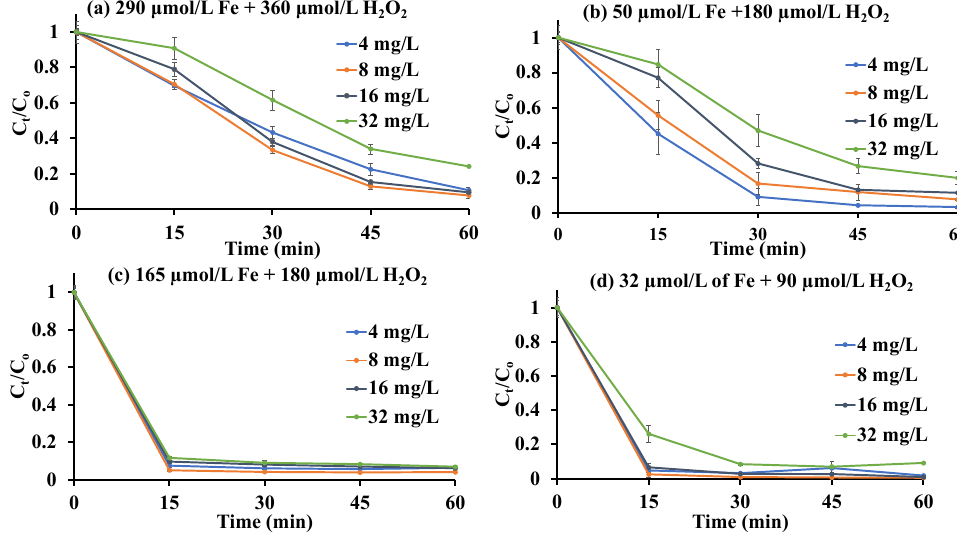
Figure 5. Degradation of MB at different concentrations using ( a ) 1000 mg St–Fe, ( b ) 300 mg St–Fe, ( c ) 300 mg Fe–St, and ( d ) 100 mg Fe–St at pH 4.